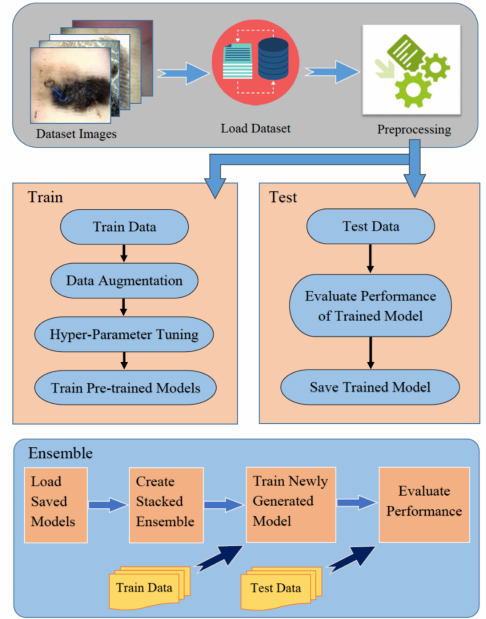
Figure 6. Block diagram of the proposed